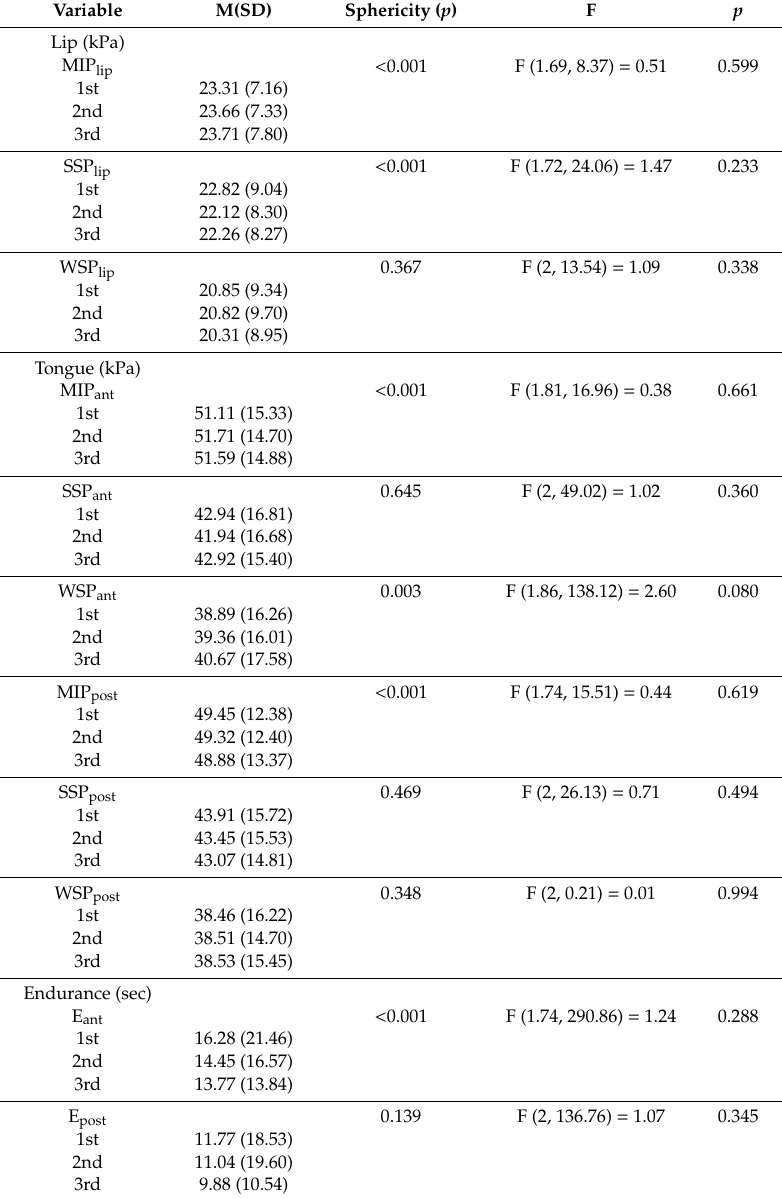
Table 5. Repeated trials for the labial and lingual pressure